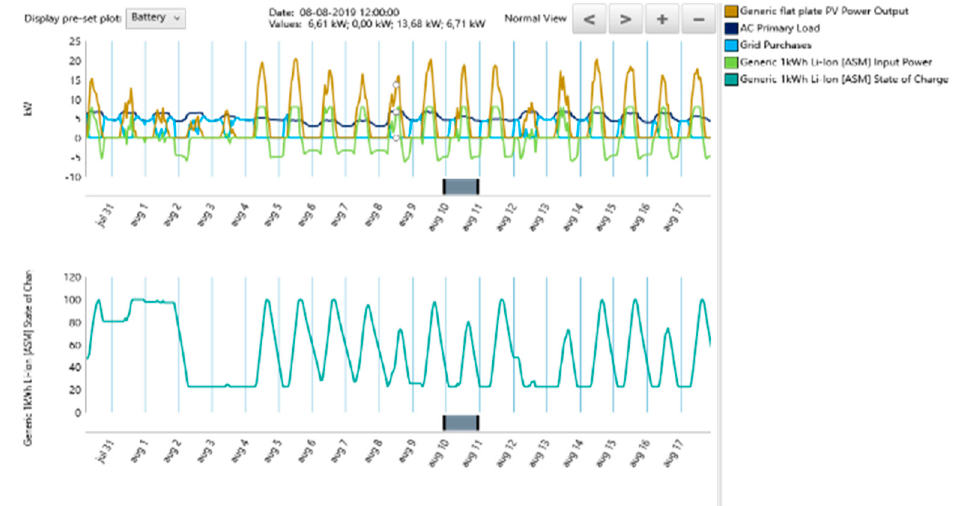
15 of 21 Figure 18. Grid and load for System 2 during an outage.